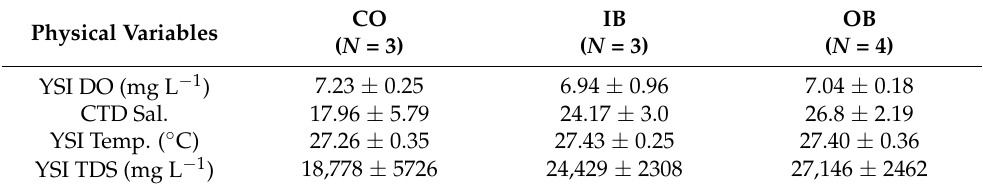
Table 2. Mean values and standard deviation of the physical Variables Dissolved Oxygen (DO), Salinity, Temperature and Total Dissolved Solids in CO (Coastal), IB (Inner Bay), and OB (Outer